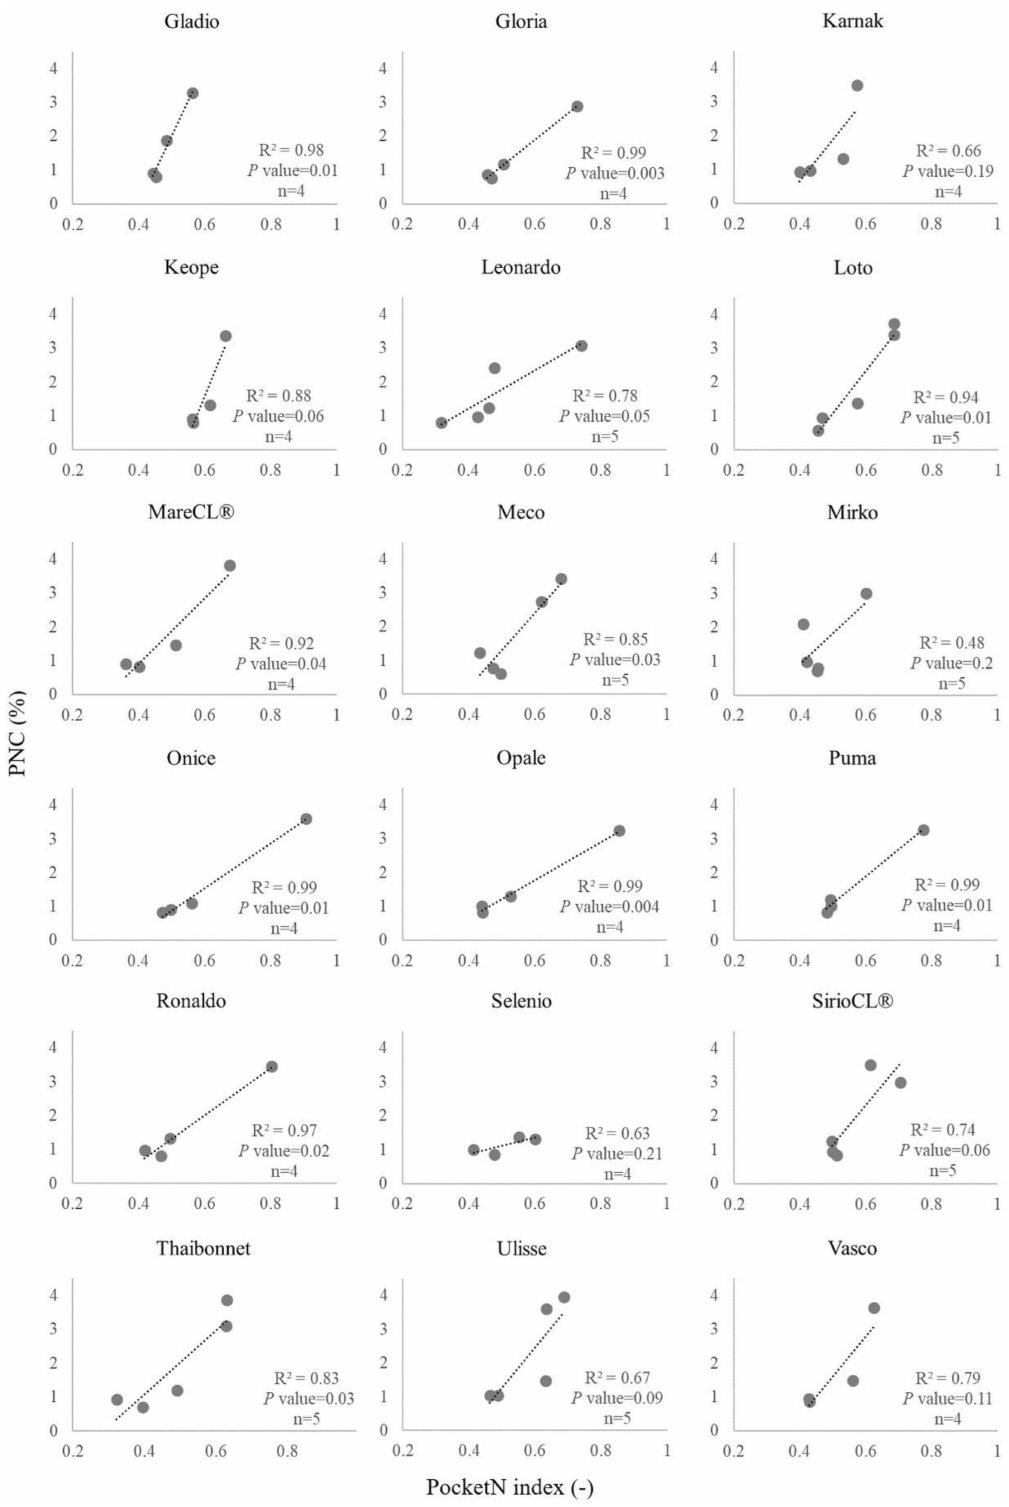
Figure A2. Relationships between the PocketN index (–) and reference plant nitrogen content (PNC) (%, from elemental analyzer) for eighteen rice cultivars included in the study. See also Table 1. These relationships were used to derive cultivar-specific calibration curves to estimate PNC using